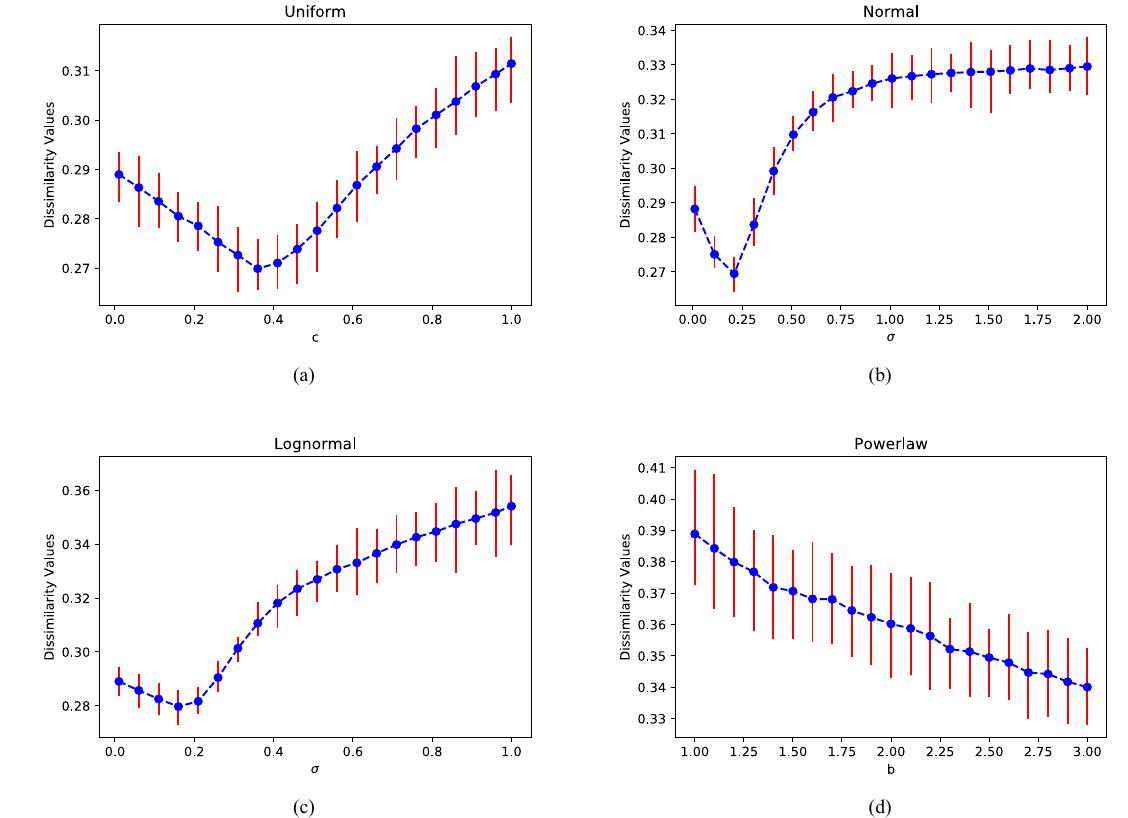
Figure 1. Comparisons between complete graphs with different weights or not. The weights are drawn from ( a ) Uniform distribution U [ 1 − c , 1 + c ] ( 0 ≤ c ≤ 1 ) ; ( b ) Normal distribution X ∼ N ( 1, σ 2 ) ; ( c ) Lognormal distribution lnX ∼ N (µ , σ 2 ) ; ( d ) Power-law distribution f ( x , b ) = b / x b + 1